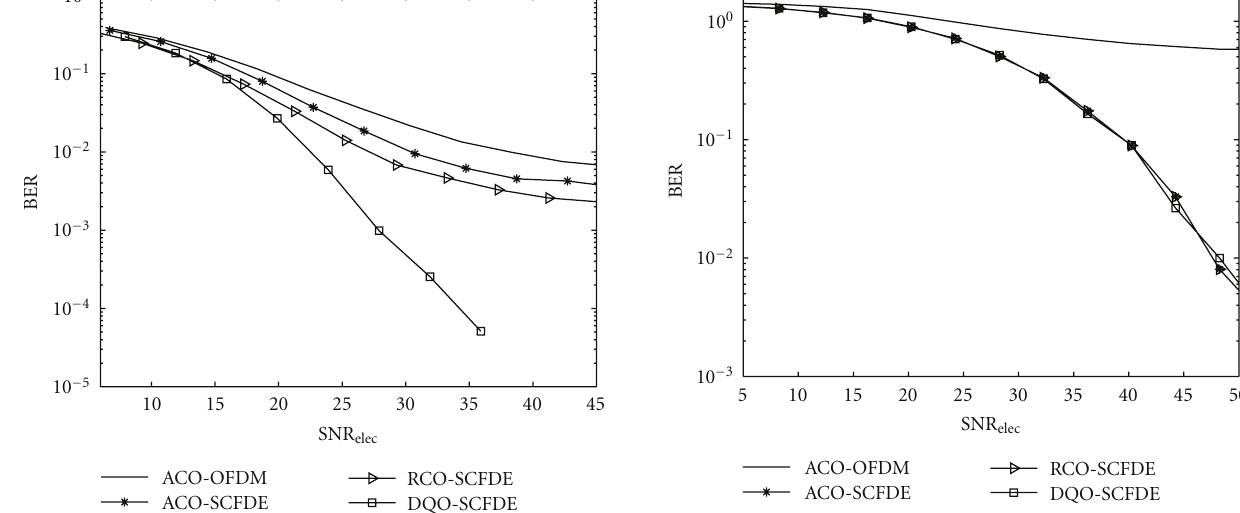
Figure 12: MMSE BER comparison of ACO-OFDM, ACO-SCFDE, RCO-SCFDE, and DQO-SCFDE with N = 64, QPSK input symbols with average power 0.5 W, L = 3.